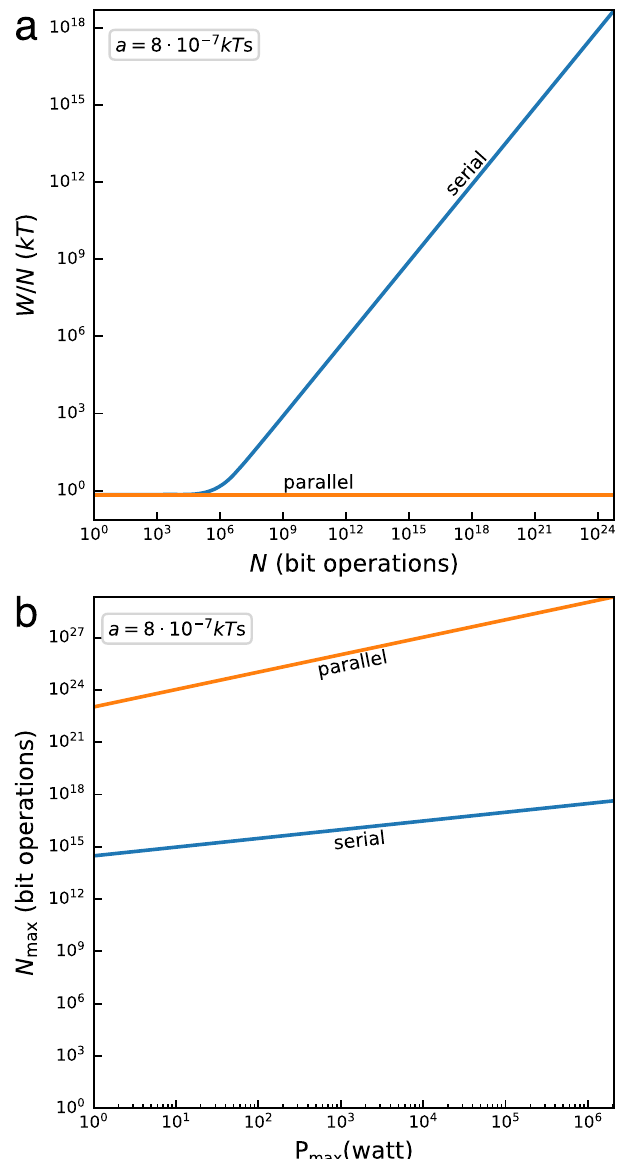
Fig. 2 | Finite-time Landauer bound for ideal serial and parallel computers. a Energyconsumptionperoperation, W / N ,forsolvingafullyparallelizableproblem of size N by an ideal serial, Eq. (3) (blue), and parallel, Eq. (4) (orange), computer. The energetic cost diverges with N for an ideal serial computer and remains con- stantforanidealparallelcomputer. b Maximalnumberofbitoperations N ser max N par max thatcanbeperformedbyanidealserial,Eq.(5)(blue),andparallel,Eq.(6)(orange), computerinthe fi nitetime T =1swithinagivenpowerbudget P max .Parametersare T =1 K, b =1 and a =8 ⋅ 10 − 7 kT